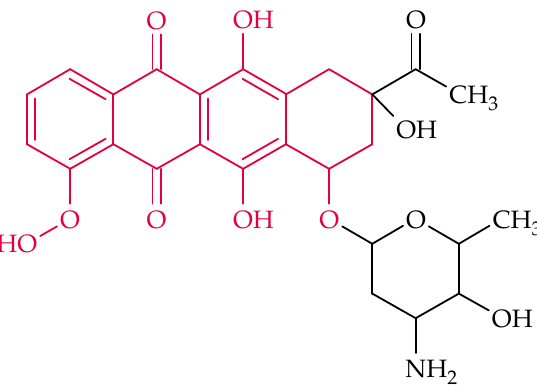
Figure 4. Chemical structure of daunomycin. The basic structure of the anthracyclines is marked in red. Daunomycin